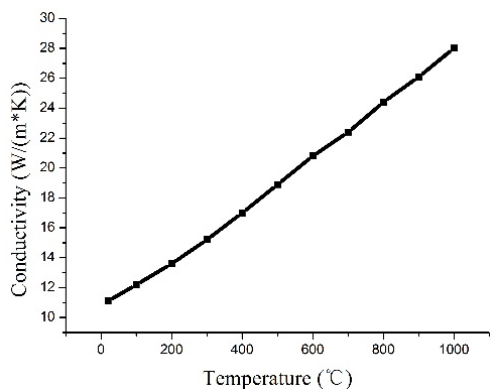
Figure 7. Specific heat of Inconel